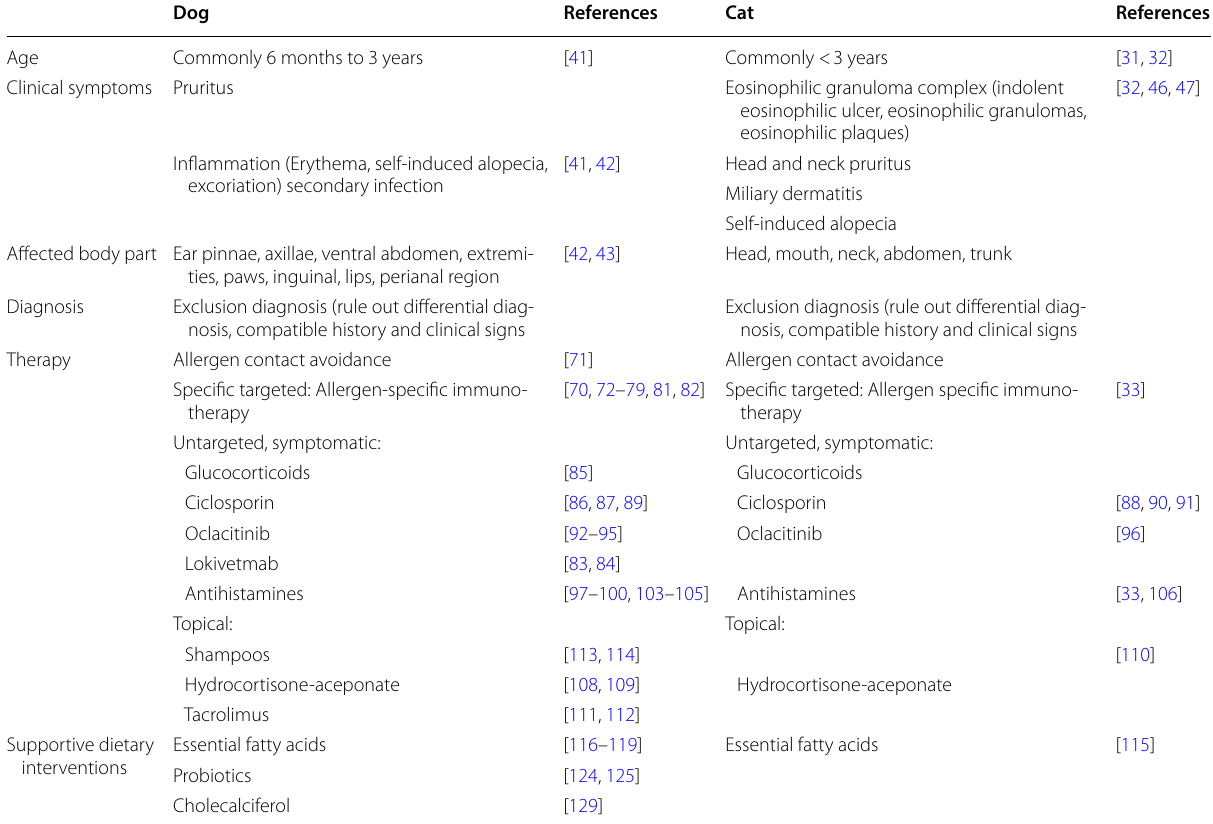
Table 3 Clinical features, diagnosis and treatments of atopic dermatitis for small animals